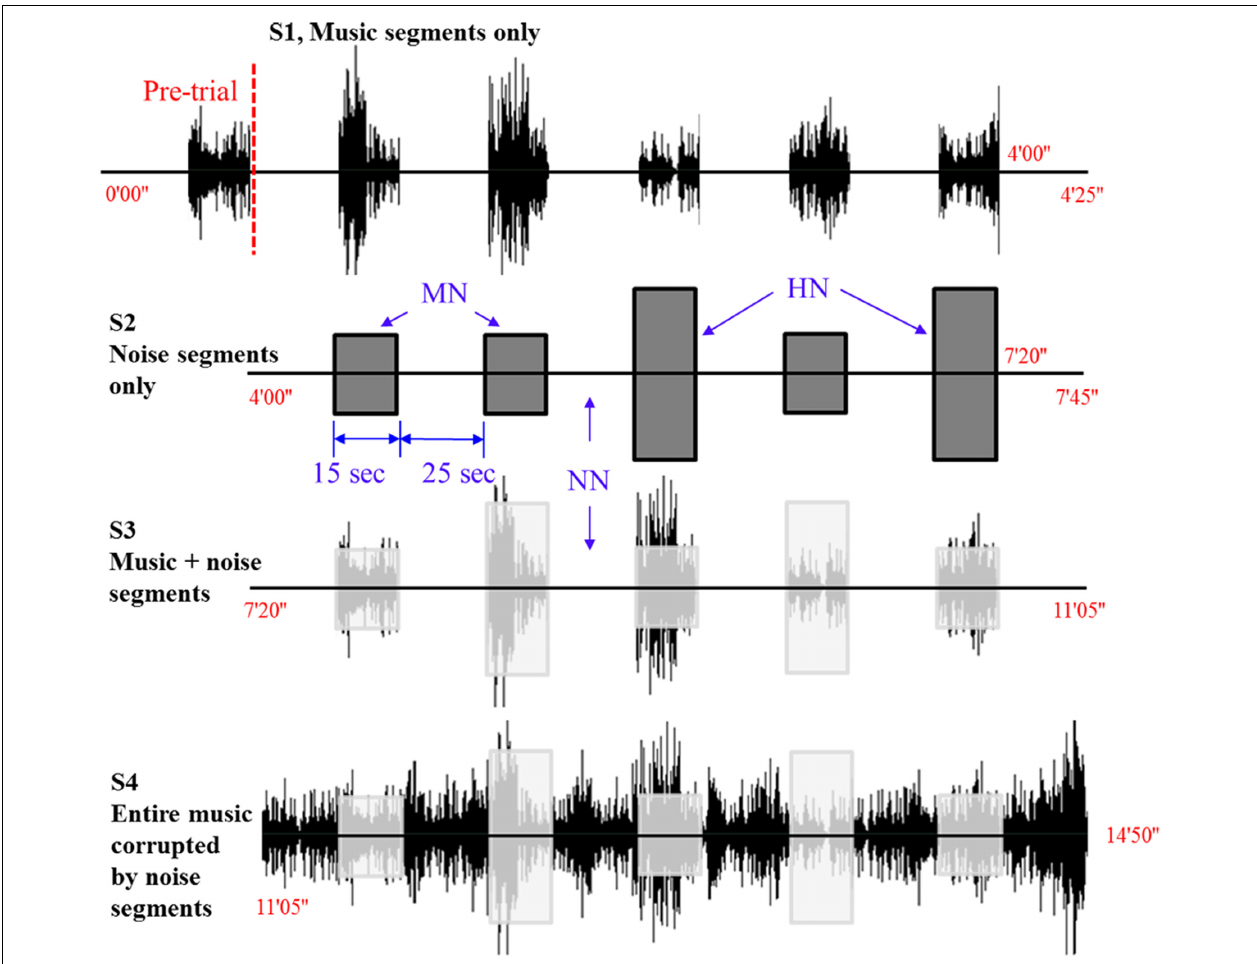
FIGURE 1 | Experimental paradigm. Four different sound conditions. The level of noise (i.e., NN, no noise; MN, mid-level noise; HN, high-level noise) changes in a pseudo-random